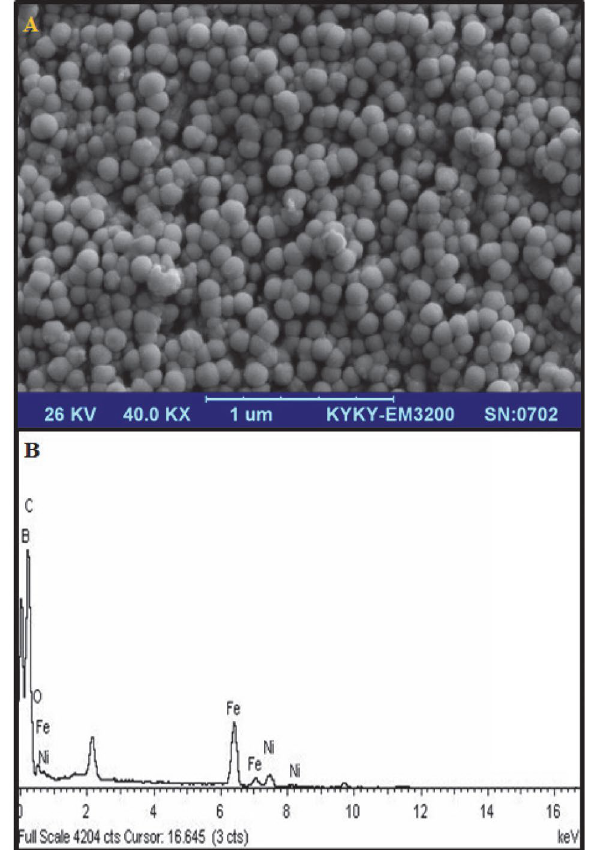
Fig. 3. (A) SEM micrographs with (B) its EDX spectra of NiFe 2 O 4